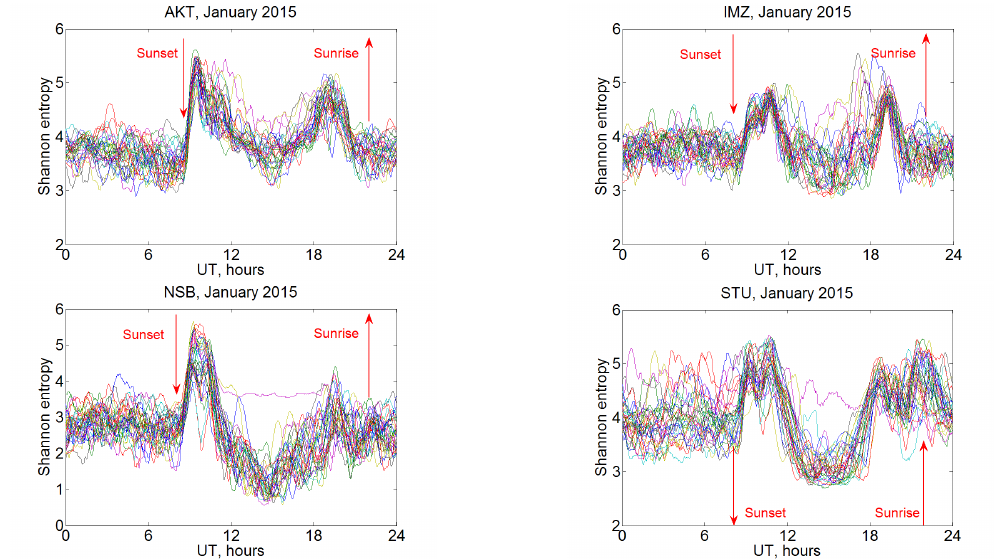
Figure 9. Example of daily variation of information entropy at the AKT, IMZ, NSB, and STU stations in January 2015; all days of the month are shown. Each curve shows an individual